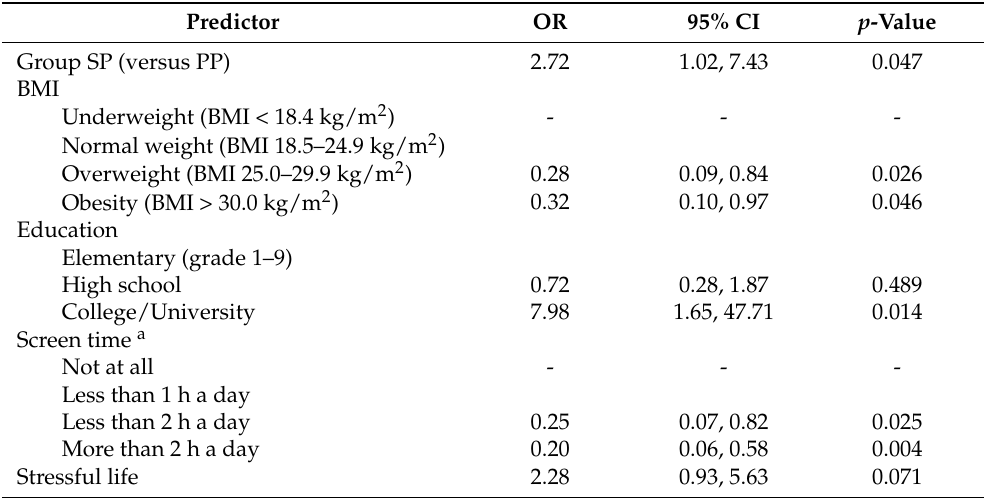
Table 3. Odds of the appropriate ICD therapy. Results of a final multivariate logistic regression model after stepwise exclusion of